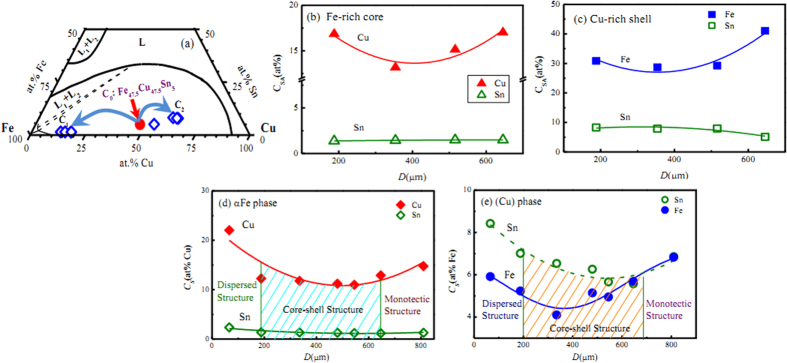
Actual solute distribution in phase separated Fe47.5Cu47.5Sn5 ternary alloy: (a) macroscopic solute separation, (b) average solute contents in Fe-rich core, (c) average solute contents in Cu-rich shell, (d) solute solubilities of αFe phase, (e) solute solubilities of (Cu) phase.